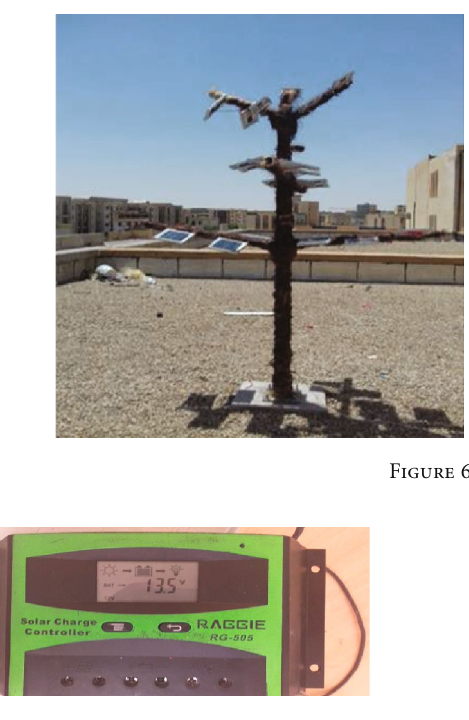
Figure 7: Used regulator.